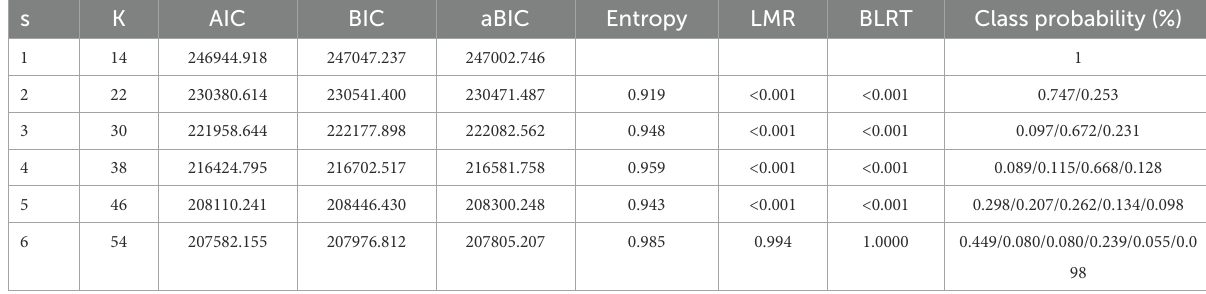
TABLE 1 Latent profile model indexes of fitting for media usage